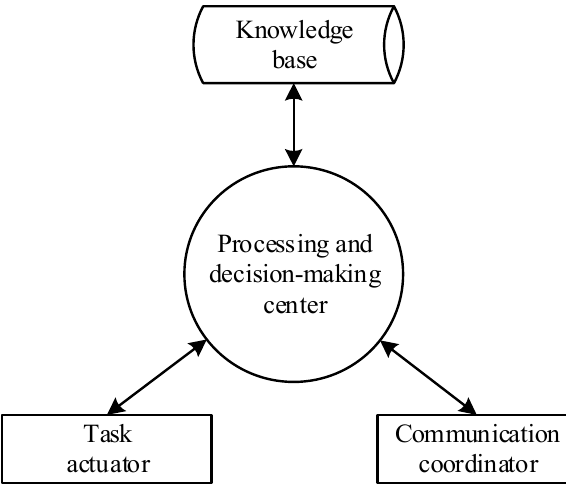
Figure 1. Agent basic structure.